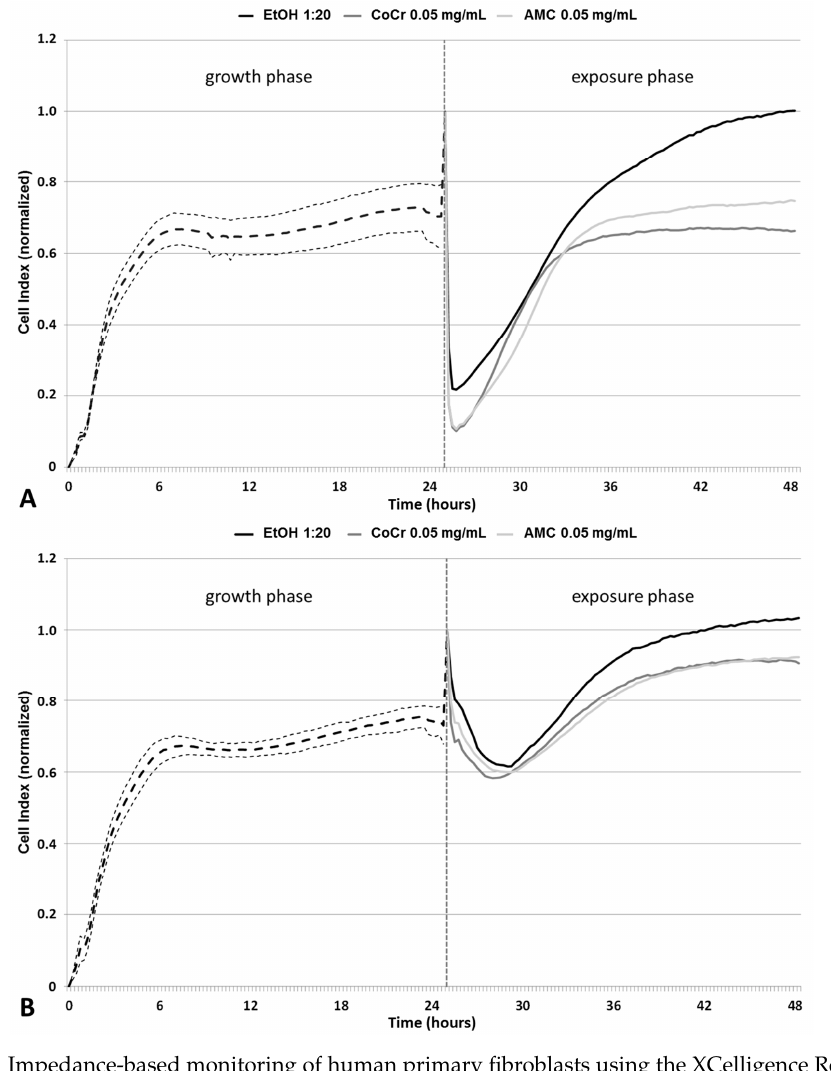
Figure 1. Impedance-based monitoring of human primary fibroblasts using the XCelligence Real Time Cell Analyzer. After 24 h of seeding, cells were exposed for another 24 h to ( A ) 0.05 mg/mL and ( B ) 0.01 mg/mL CoCr28Mo6 and AMC particles as well as the respective control. Impedance was monitored for another 24 h. Data were normalized to time point 25 h. For the growth phase, data are shown as mean value of the respective cell culture (thick dashed line) ± 95% confidence interval (fine dashed lines). Data of the exposure phase are shown as mean of three independent experiments performed in duplicates.